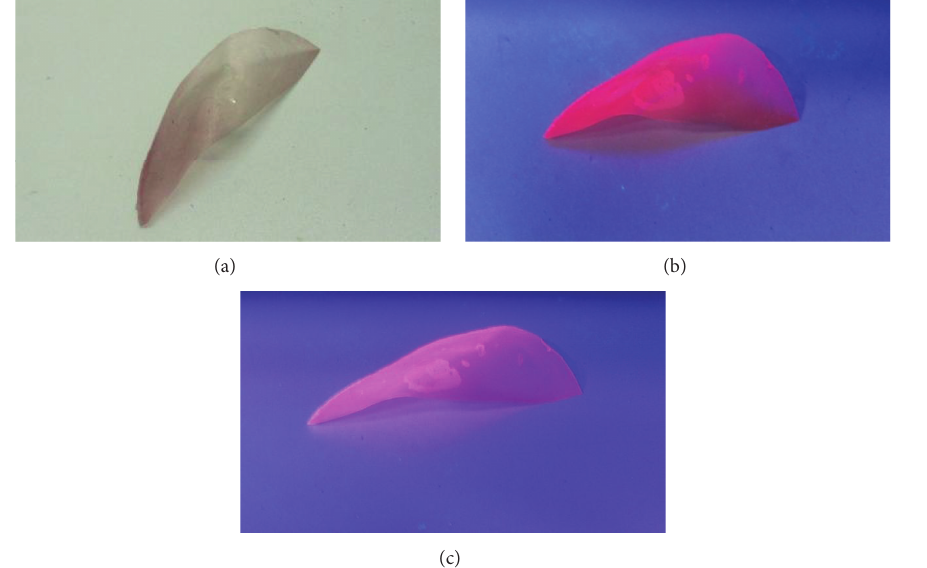
Figure 1: Au (dodecanoic acid)-thiolate clusters embedded into a polyvinyl alcohol (PVA) matrix (1% by weight) observed under visible light (a), 365 nm ultraviolet light (b), and 254nm ultraviolet light